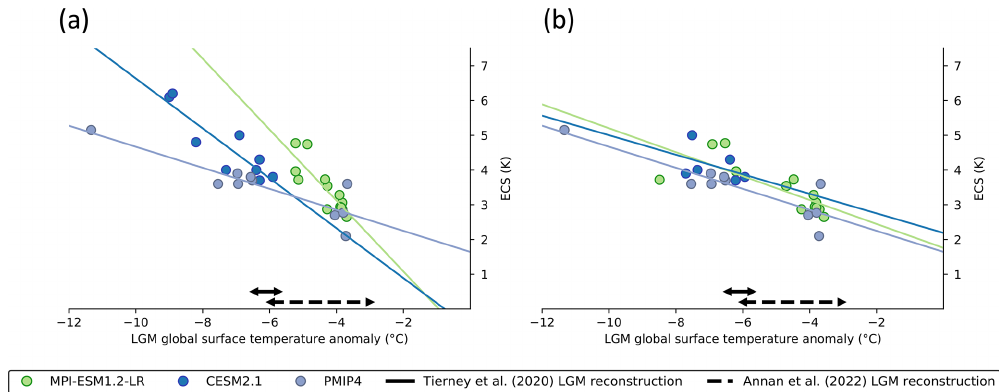
Figure 13. Comparison of the emergent-constraint relationship between global LGM surface temperature anomaly and ECS in the multi- model ensemble of PMIP4, the single-model ensemble of MPI-ESM1.2-LR (this study) and the single-model ensemble of CESM2.1 (Zhu et al., 2022a). (a) Surface temperatures are averaged over the last 50 years; (b) surface temperatures are extrapolated by linear regression until top-of-atmosphere imbalance reaches 0Wm − 2 . The LGM global surface temperature reconstruction of Tierney et al. (2020) is shown as well as the LGM global surface air temperature reconstruction of Annan et al.